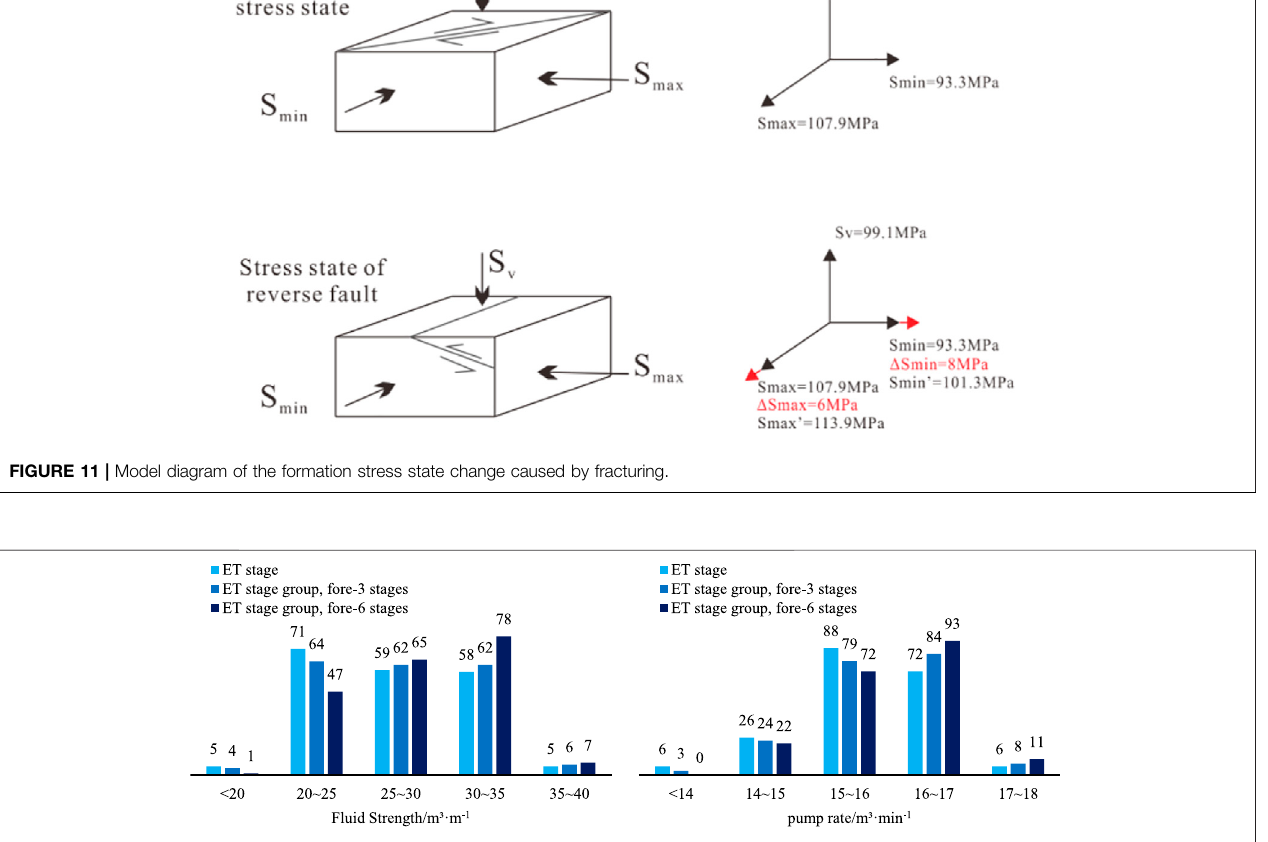
Frontiers in Energy Research |